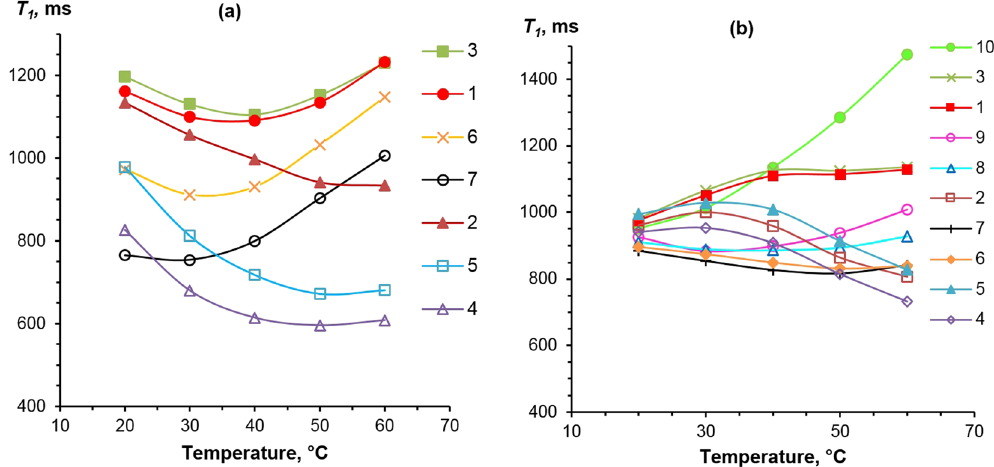
Figure 6. T 1 relaxation times for [C 2 MIM][OAc] ( a ) and [C 2 MIM][OOct] ( b ) as a function of temperature, taken in a high-field (400 MHz) NMR spectrometer. Series numbering corresponds to the labelling shown in Fig. 1. Uncertainties of 5% are approximately the size of data points and were omitted for clarity. Lines are given to guide the